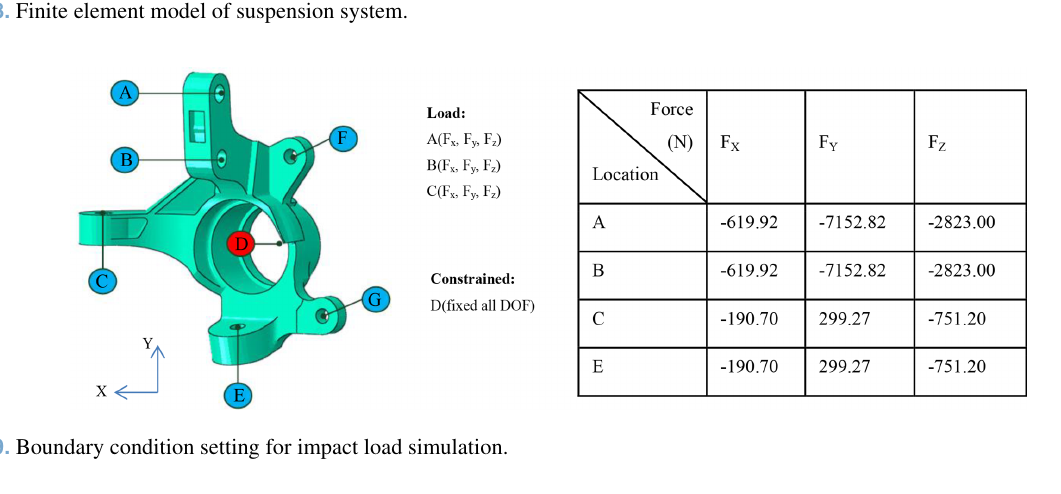
Figure 8. Finite element model of suspension system.